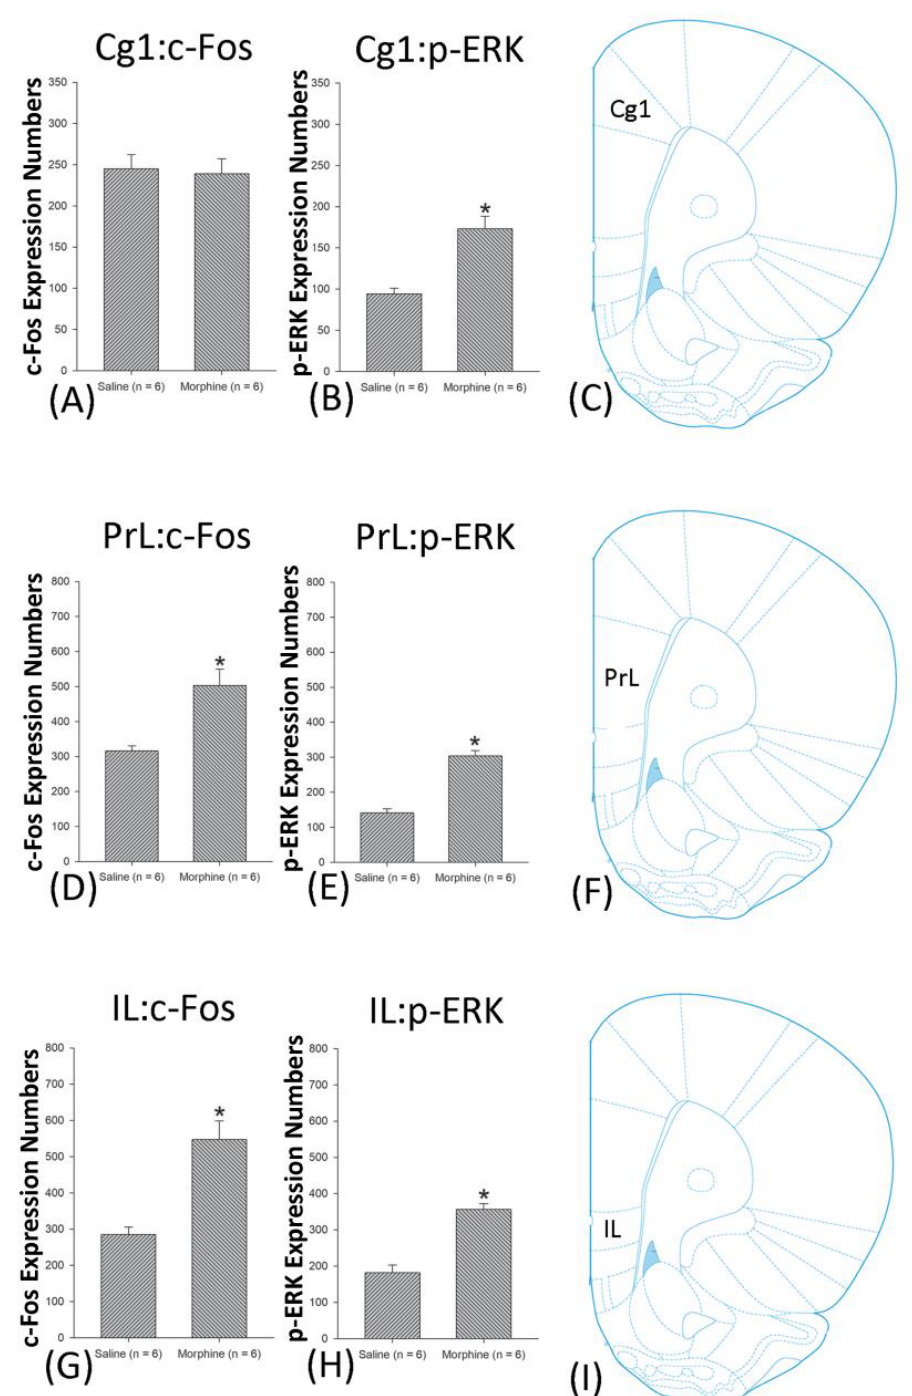
Figure 14. c-Fos or p-ERK expression in the cingulated cortex area 1 (Cg1), the prelimbic cortex (PrL), and the infralimbic cortex (IL) in reinstatement. ( A ) c-Fos and ( B ) p-ERK expression in the Cg1, ( D ) c-Fos and ( E ) p-ERK expression in the PrL, and ( G ) c-Fos and ( H ) p-ERK expression in the IL for reinstatement. ( C , F , I ) indicate a schematic representation of the Cg1, PrL, and IL. * p < 0.05 when comparing the saline and morphine groups ( n = 6 per group).